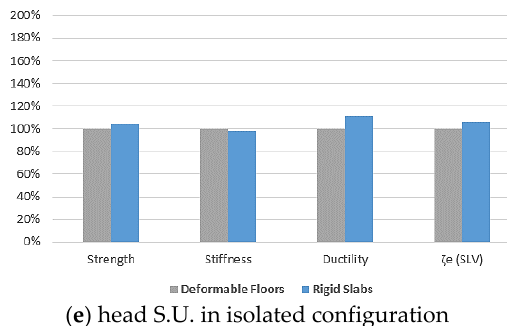
Figure 12. Influence of rigid floors on the seismic behaviour of the whole aggregate and the monitored S.Us.